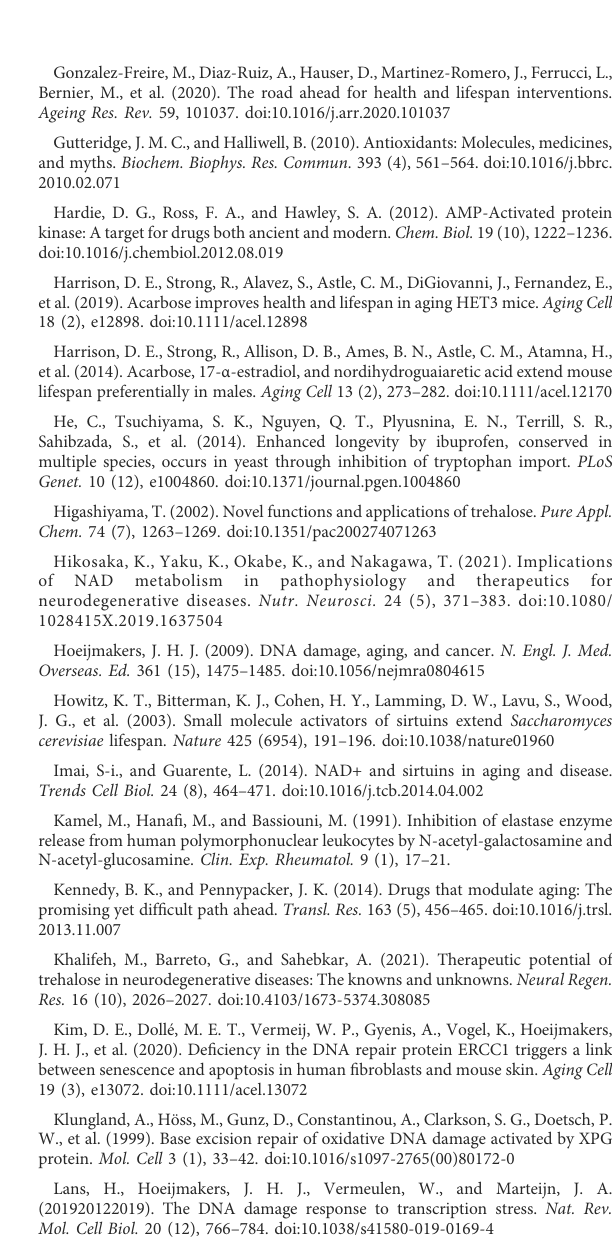
SUPPLEMENTARY TABLE S1 Overview of compounds, experimental location, delivery method, intervention start, concentration of drugs and number of male/female animals of each experimental